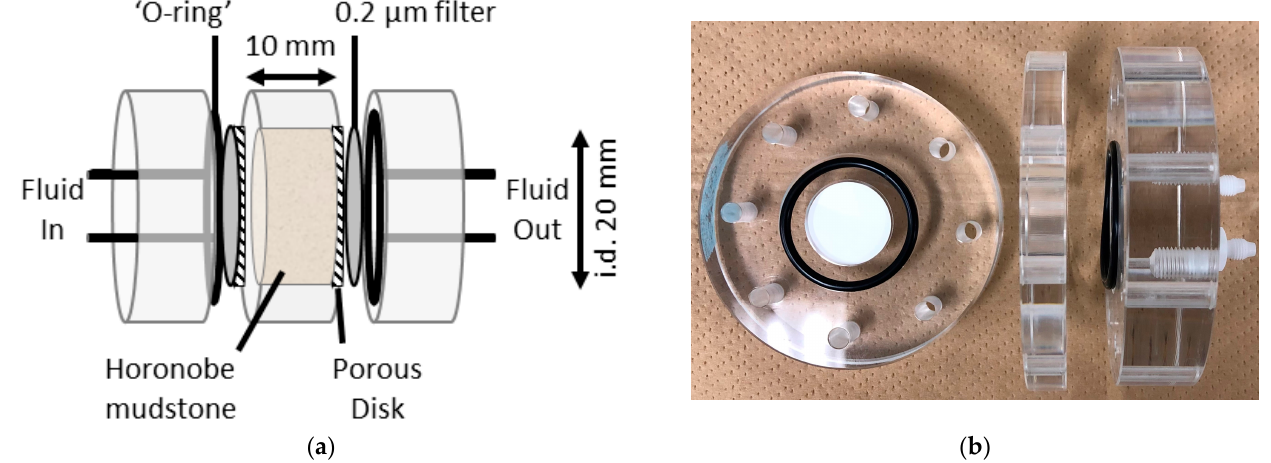
Figure 1. (a) Schematic (after [14]) and photograph (b) of small flow cell (SFC).